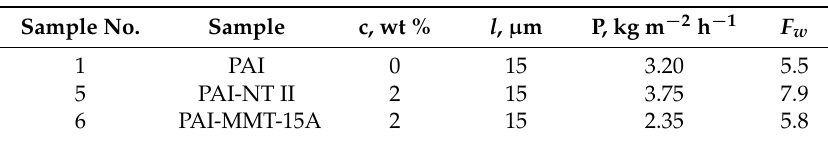
Table 3. Permeability to water of nonporous films of PAI-SNT I-III composites, in comparison with the nonporous PAI film, in pervaporation at 40 ◦ C